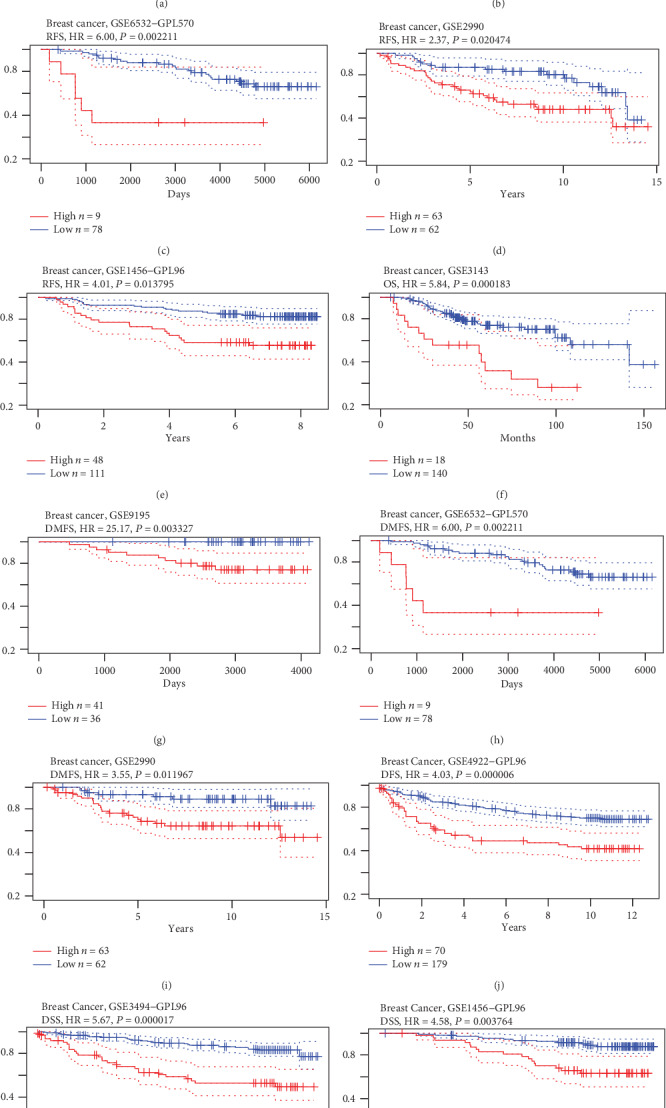
The prognostic role of HNRNPAB in BC patients. Survival curve analyses were performed with PrognoScan datasets. Hazard ratios, 95% confidence intervals, and Cox p values were automatically obtained from the website. Higher expression of HNRNPAB indicated unfavorable outcomes in BC patients.